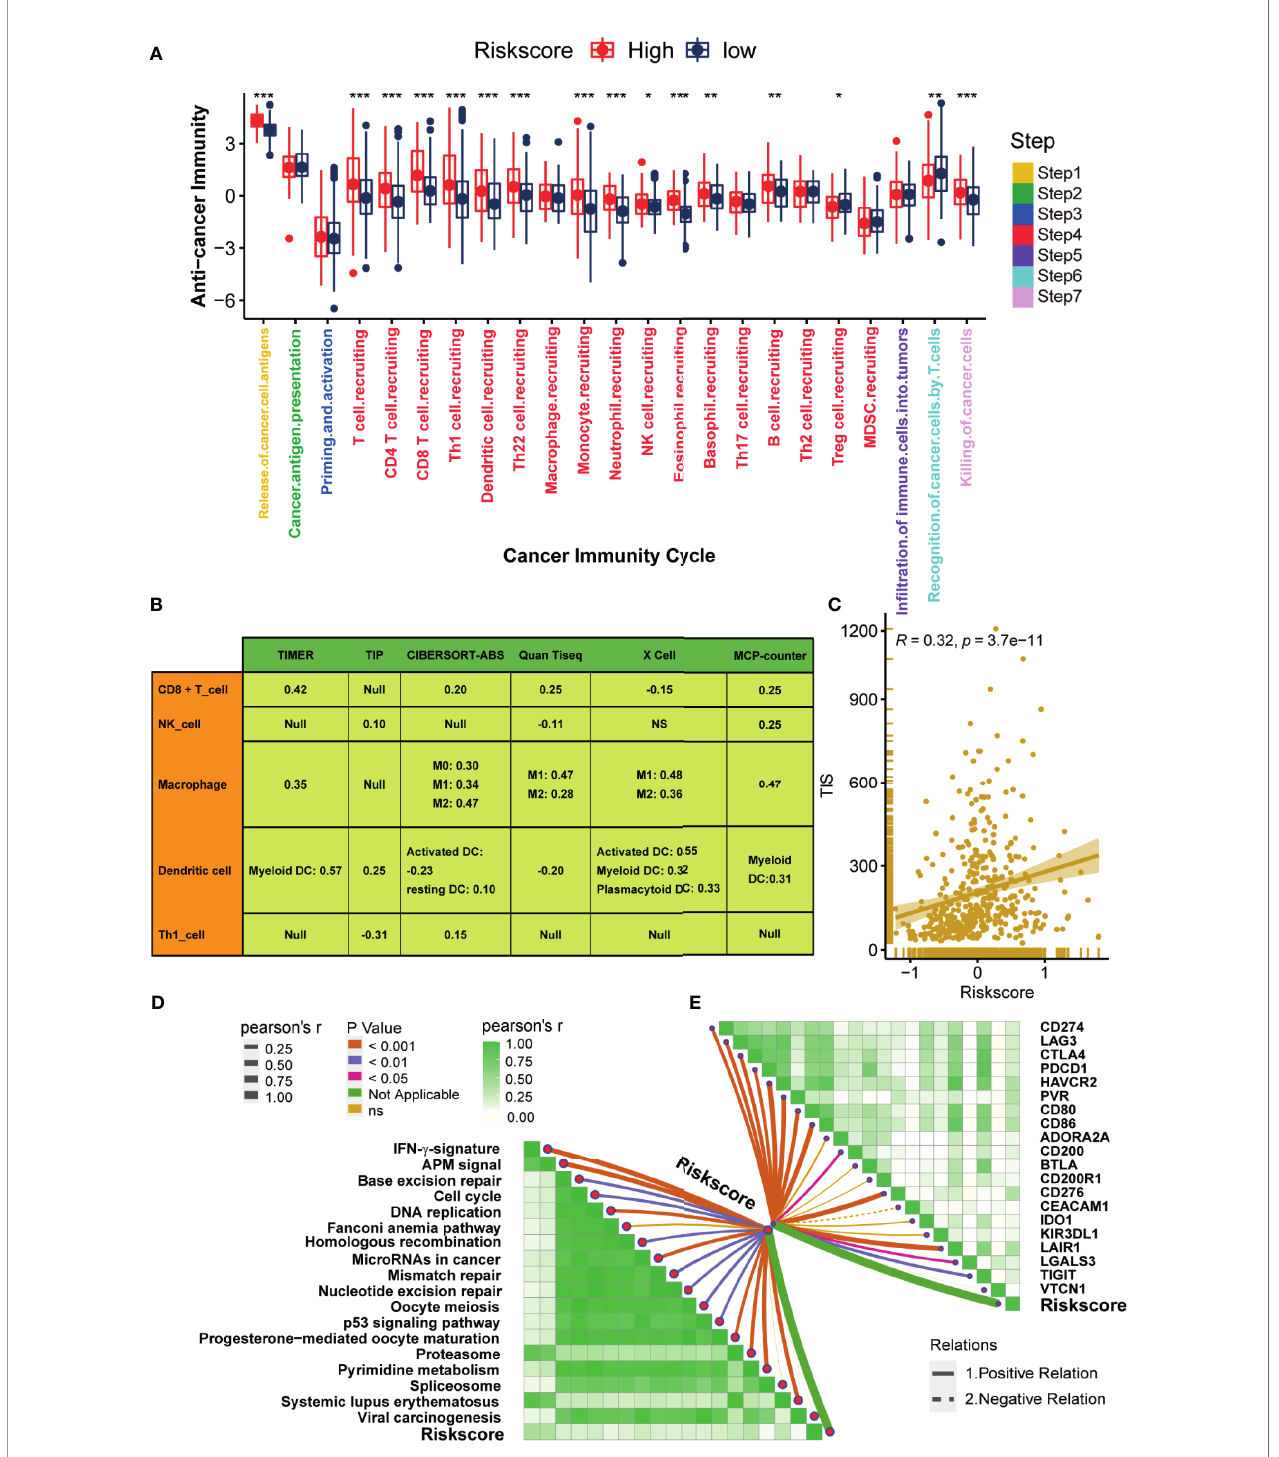
FIGURE 4 | Hypoxia risk score correlated with immune characters of TME and predicted the clinical response of ICB. (A) Differences in activities of the cancer immunity cycles between high- and low-risk score groups. (B) The correlations between the hypoxia risk score and several immune cells, including CD8 + T cells, NK cells, Macrophage, Dendritic cells, and TH1 cells. (C) The correlations between the hypoxia risk score and T cell in fl amed score (TIS). (D) The correlations between hypoxia risk score and the enrichment scores of immunotherapy-predicted pathways. (E) The correlations between hypoxia risk score and immune checkpoints. (*P < 0.05; **P < 0.01; ***P <